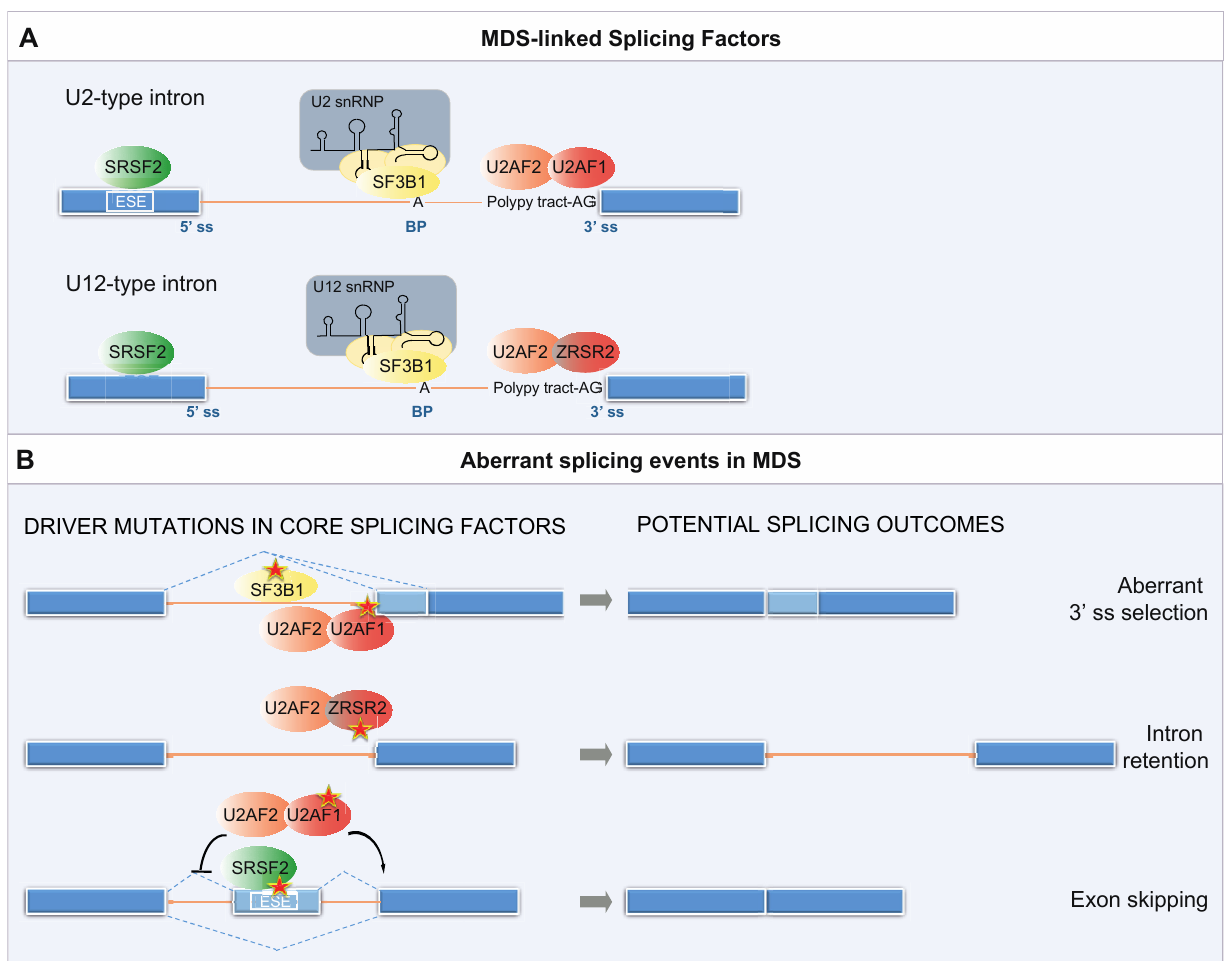
Figure 2. Splicing factors mutations in MDS. ( A ) Physiological role of MDS-linked SFs in spliceosome assembly. Intron removal requires the recognition of regulatory RNA sequence motifs by core components of the spliceosome followed by cleavage at conserved sequences called splice sites at the 5 (cid:48) and 3 (cid:48) ends of the introns (5 (cid:48) ss and 3 (cid:48) ss). Another important sequence is located 18–40 nucleotides upstream from the 3 (cid:48) end of an intron. This sequence, termed the branch point (BP), always contains an adenine, but it is otherwise loosely conserved. Splice site recognition additionally requires Exonic Splicing Enhancers (ESEs). ESEs participate in both alternative and constitutive splicing, and many of them act as binding sites for members of the SR protein family, among which SRSF2. U1, U2, U4/U6, and U5 snRNPs are fundamental for the recognition of the splice sites and in the catalysis of the splicing reaction. Each of the five snRNPs contains one small nuclear RNA (snRNA) and a number of protein components. The initial intron recognition is achieved by U1 snRNP, which binds to the 5 (cid:48) ss through base-pairing between the 5 (cid:48) ss and the 5 (cid:48) end of U1 snRNA, and by the interaction of splicing factor 1 (SF1/mBBP) with the BP; the 3 (cid:48) ss is bound by the U2 auxiliary factor U2AF (U2AF1/2 heterodimer). Subsequently, SF1 is displaced and U2AF recruits the U2 snRNP, in which the multi-protein component SF3b harbors the subunit SF3B1, to the BP sequence, forming the pre-spliceosome. The pre-spliceosome then associates with the preassembled U4/U6.U5 tri-snRNP and after several rearrangements gives rise to the catalytically active spliceosome. In addition to the major U2-dependent spliceosome, most metazoans contain a second distinct pre-mRNA splicing machinery called the minor (U12-dependent) spliceosome. U12-type introns account for less than 0.5% of all introns in any given genome and are enriched in specific gene families, such as the mitogen activated-protein kinase, voltage-gated sodium and calcium ion channels, and E2F transcription factors [160]. ZRSR2 is a U2AF1-related protein that interacts with U2AF2 and is required for the recognition of the minor introns’ 3 (cid:48) ss. ( B ) Aberrant alternative splicing events caused by the MDS-linked SFs’ mutations. Mutations in different SFs result in distinct mechanistic alterations in splicing. SF3B1 and U2AF1 mutations mainly alter 3 (cid:48) ss selection through recognition of a cryptic 3 (cid:48) splice site, and enhance aberrant exon inclusion through the selection of non-canonical BPs. Aberrant splicing caused by ZRSR2 mutations primarily consist in intron retention. Finally, SRSF2 mutations alter its ability to recognize a splicing enhancer motif, resulting in the majority of cases in exon